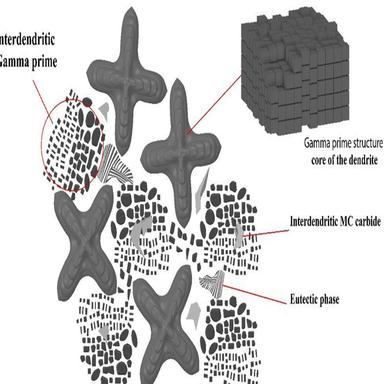
Schematic structure of the precipitation hardening nickel-based superalloy.